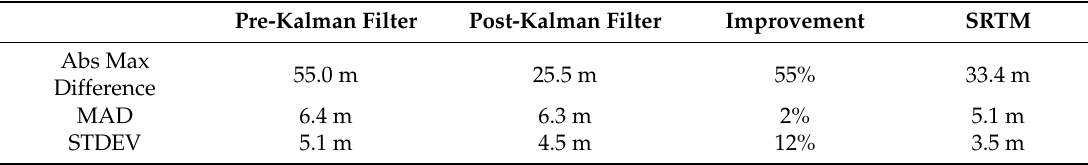
Table 3. Statistical evaluation of elevation differences in respect to the photogrammetric reference